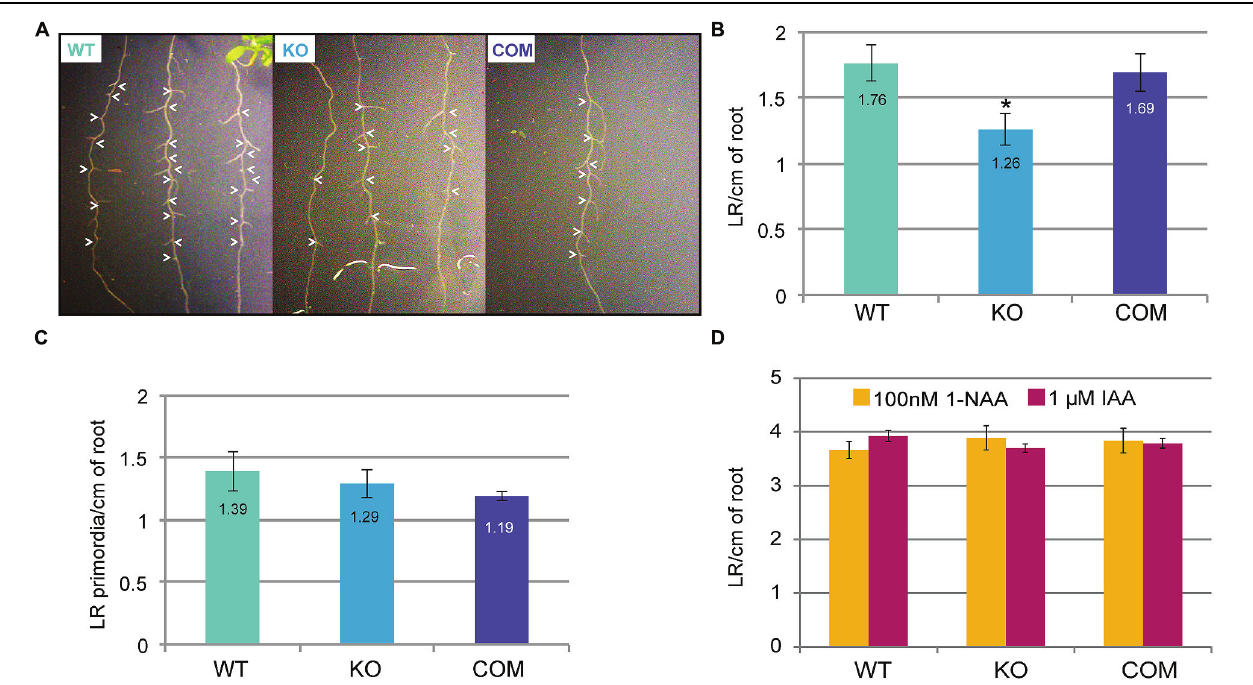
FIGURE 1 | Loss of TGN-localized SYP41-interacting protein (TNO1) function delays lateral root emergence in an auxin-dependent fashion. (A) Representative images showing emergent lateral roots (white arrowheads) in wild-type (WT), tno1 (KO), and tno1 complemented (COM) lines. (B) Emergent lateral root density of 10-day-old seedlings grown on 0.25 × Murashige–Skoog (MS) medium (with 1% sucrose) was calculated by dividing the number of emerging lateral roots by root length. (C) Lateral root primordia density of 7-day-old seedlings was calculated by counting the number of primordia after microscopic analysis of cleared roots and dividing it by the root length. (D) Emergent LR density of 10-day-old seedlings, 5 days after transfer to medium containing 100 nM 1-napthylacetic acid (NAA) or 1 µ M indoleacetic acid (IAA). All values represent analysis of three biological replicates with 15–20 seedlings for each set. Error bars indicate standard errors of the means. Asterisk indicates statistically significant difference ( P < 0.05) by Student’s t -test.